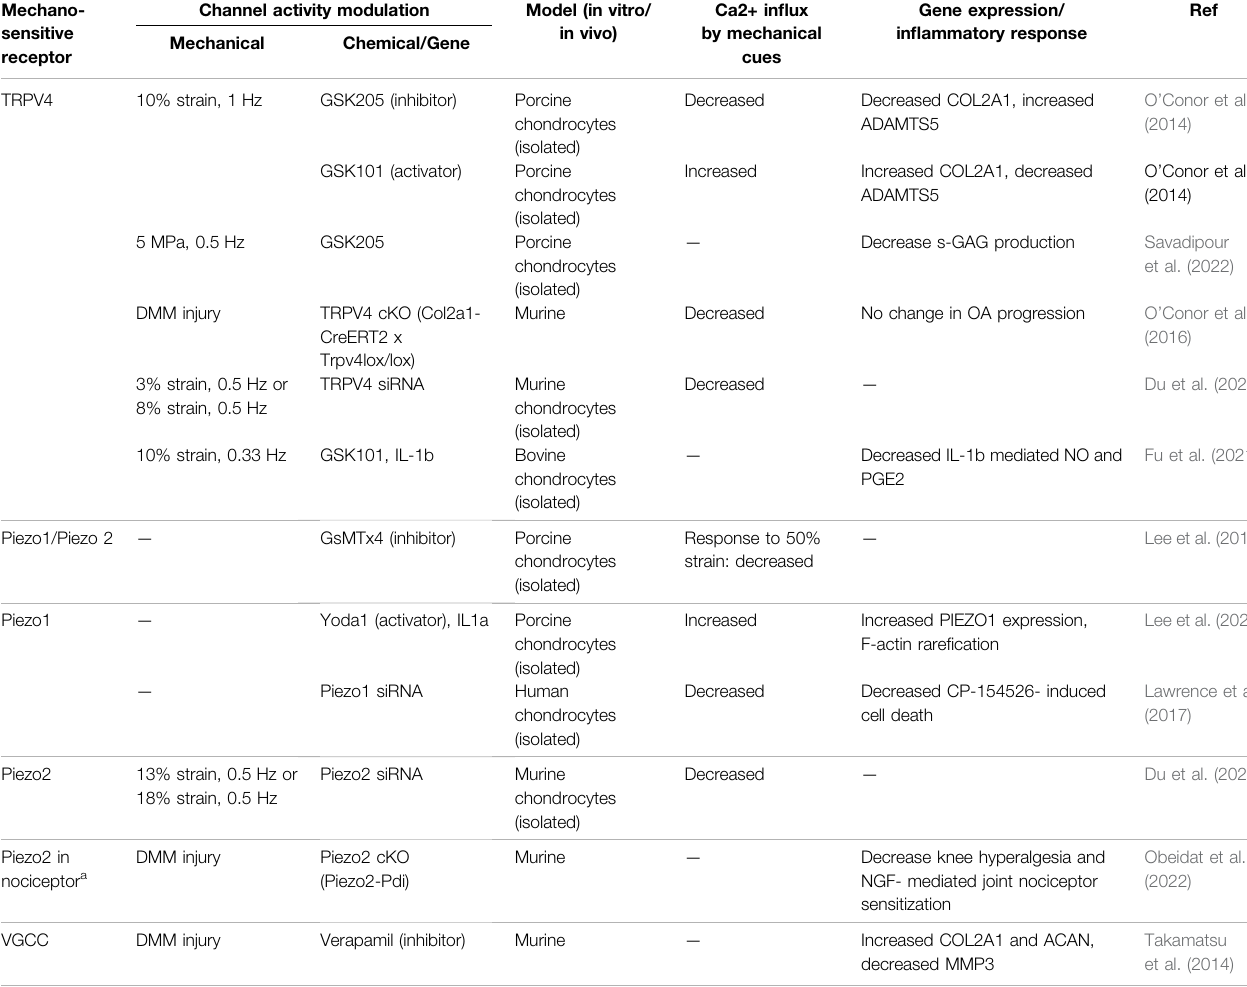
TABLE 1 | Selected studies demonstrating mechanosensitive ion channel activity, Ca2+ response to mechanical cues, and biosynthetic activities. Mechano-